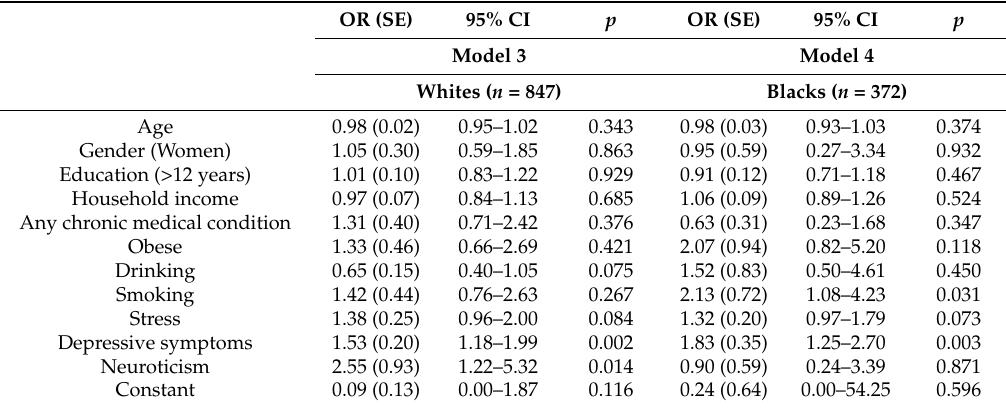
Table 3. Summary of logistic regression models on the association baseline neuroticism and CIDI-based major depressive episode 25 years later based on race ( n =